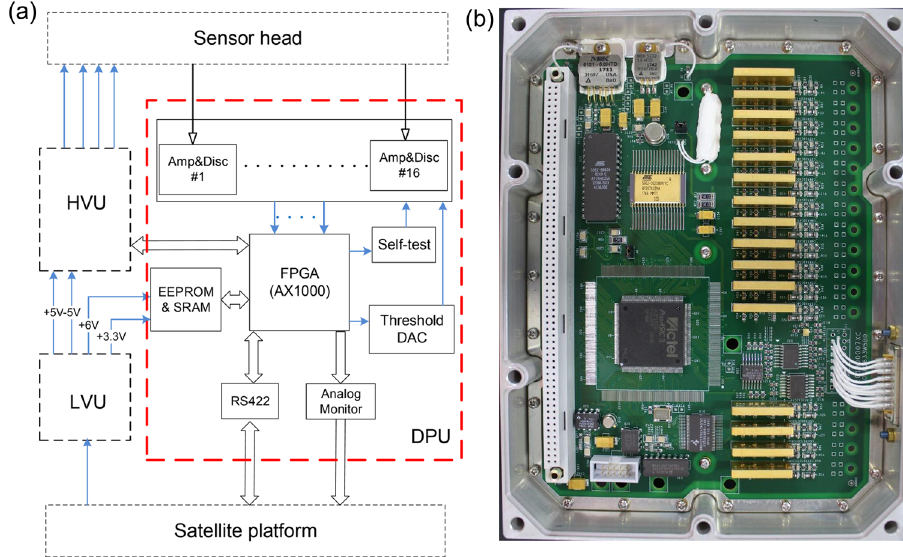
Figure 2: ( a ) Schematics of the DPU and ( b ) photograph of its PCB.